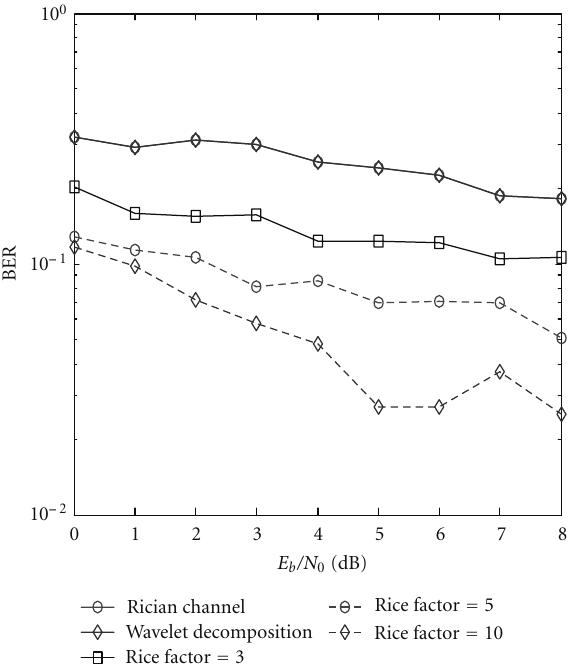
Figure 12: BER performance through Rician channel.